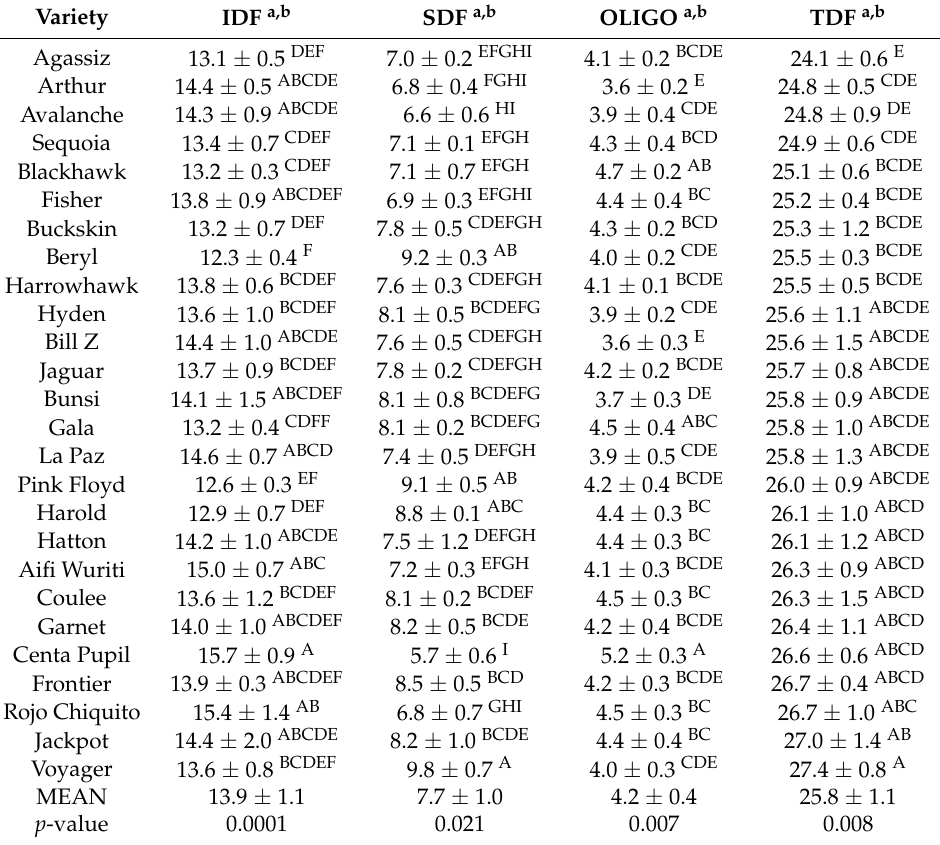
Table 2. Dietary fiber content of common bean